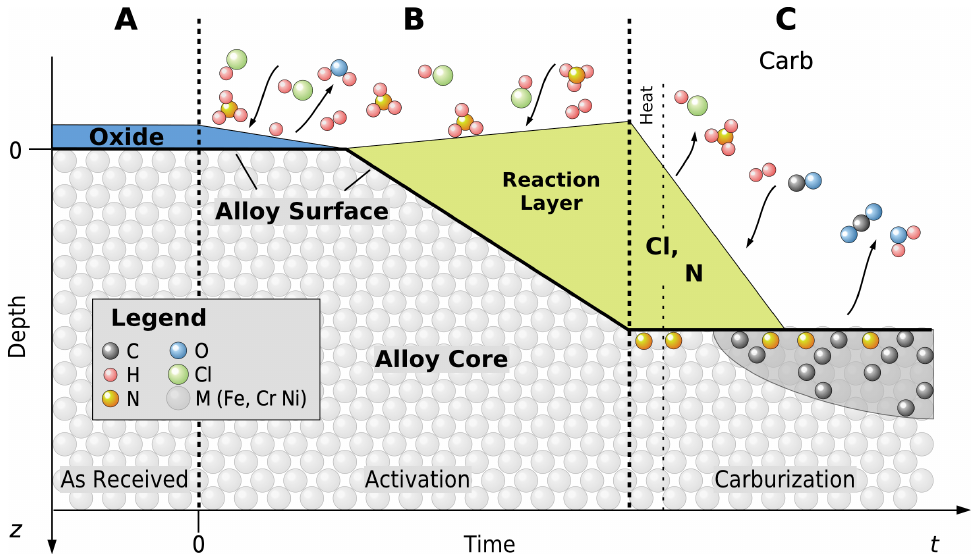
Figure 15. Model for the microscopic mechanism of A T —surface activation via solid-reagent pyrolysis—and subsequent low-temperature gas-phase carburization of austenitic Cr-bearing alloys. The bold line shows the height z of the alloy surface as a function of time t . ( A ) Initial state, alloy surface passivated by oxide film. ( B ) Alloy surface reacts with molecules generated by solid-reagent pyrolysis, e.g., NH 3 , HCl. Result: Oxide film removal, reaction layer consisting of ammonium–iron chlorides and chromium ammine chloride, provisional passivation. ( C ) Continuous low-temperature carburization, Carb. In the beginning, heating to carburization temperature and H 2 supply induce decomposition of reaction layer. Decomposition generates activity of Cl and